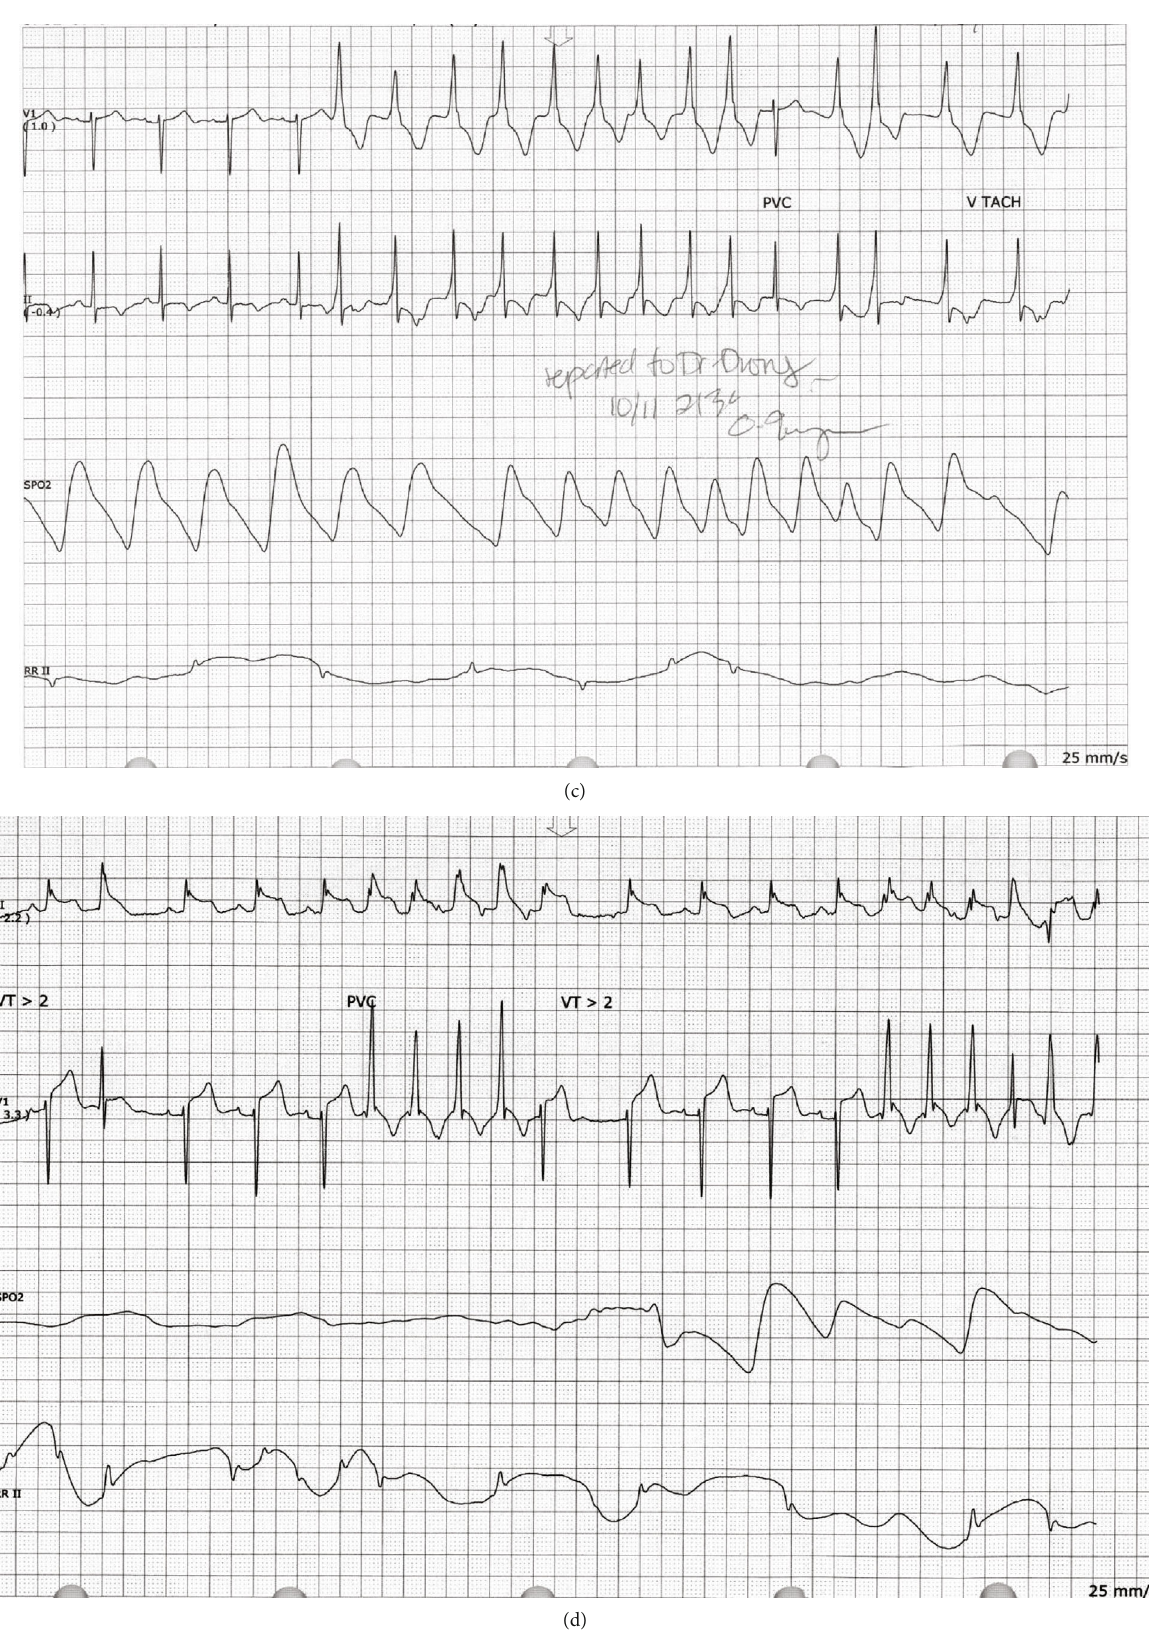
Figure 1: (a) Normal sinus rhythm, no ST segment elevations or depressions, and nonspeci fi c T wave abnormalities. (b) Dynamic ST elevation on ECG. (c, d) Nonsustained ventricular